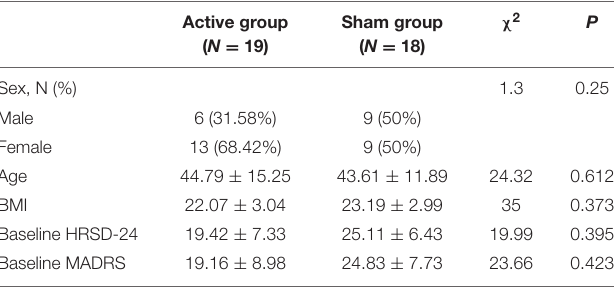
TABLE 1 | Clinical characteristics of active and sham groups at baseline.